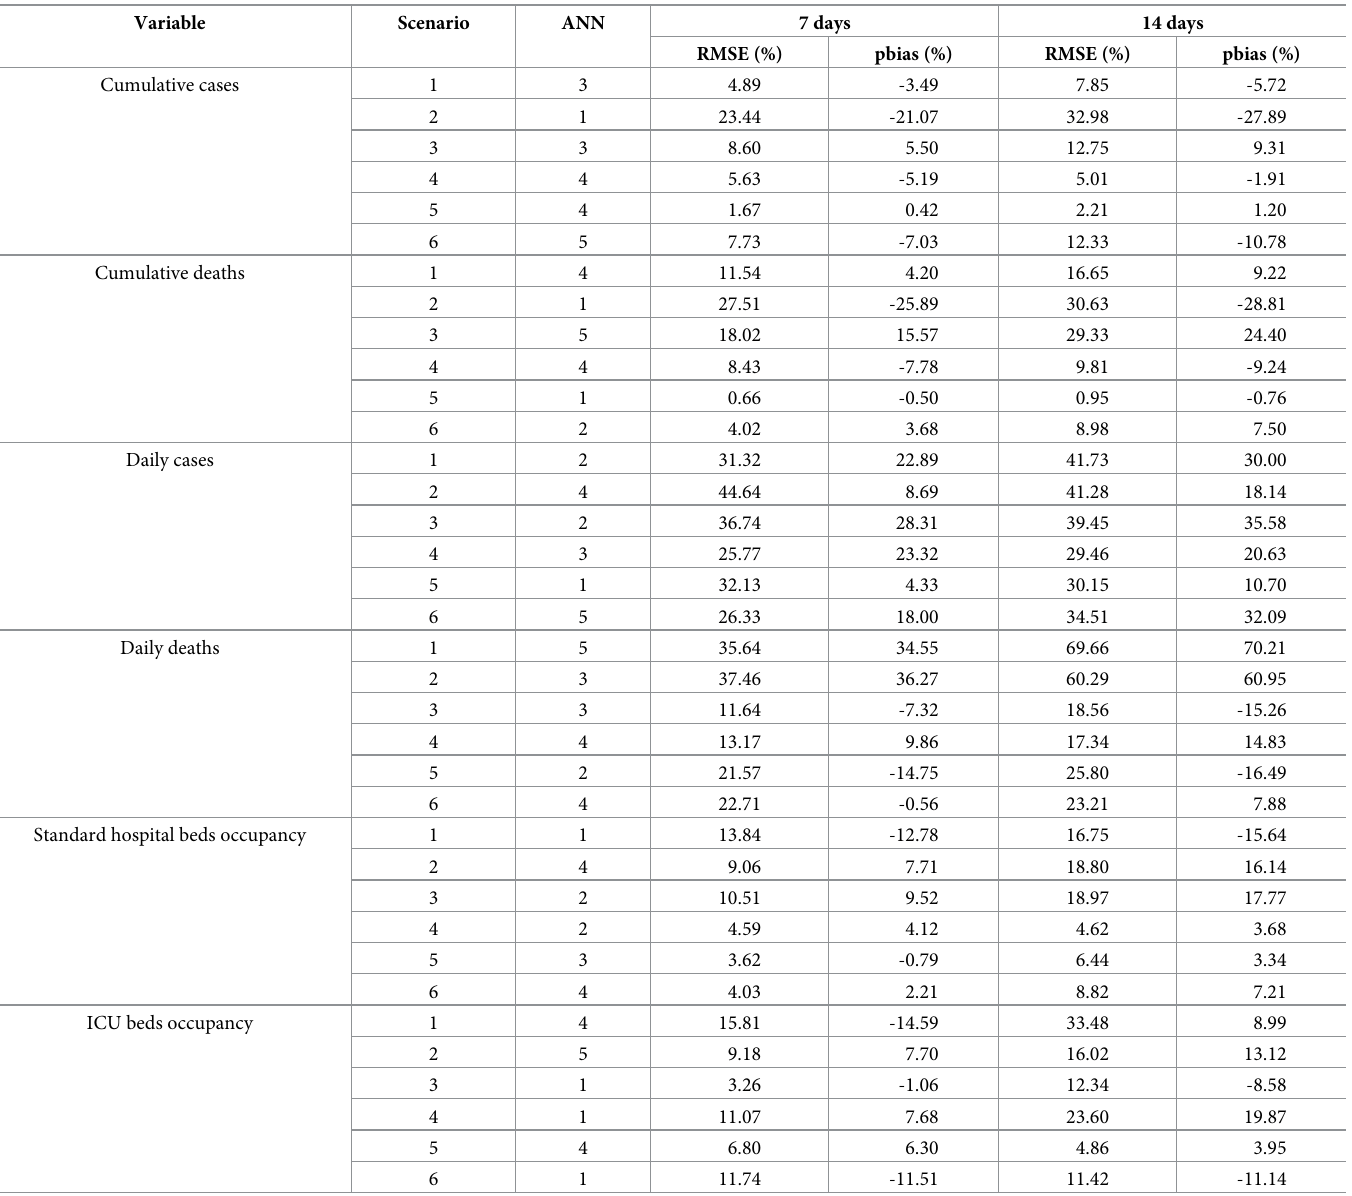
Table 2. Prediction and trend measures used to validate the